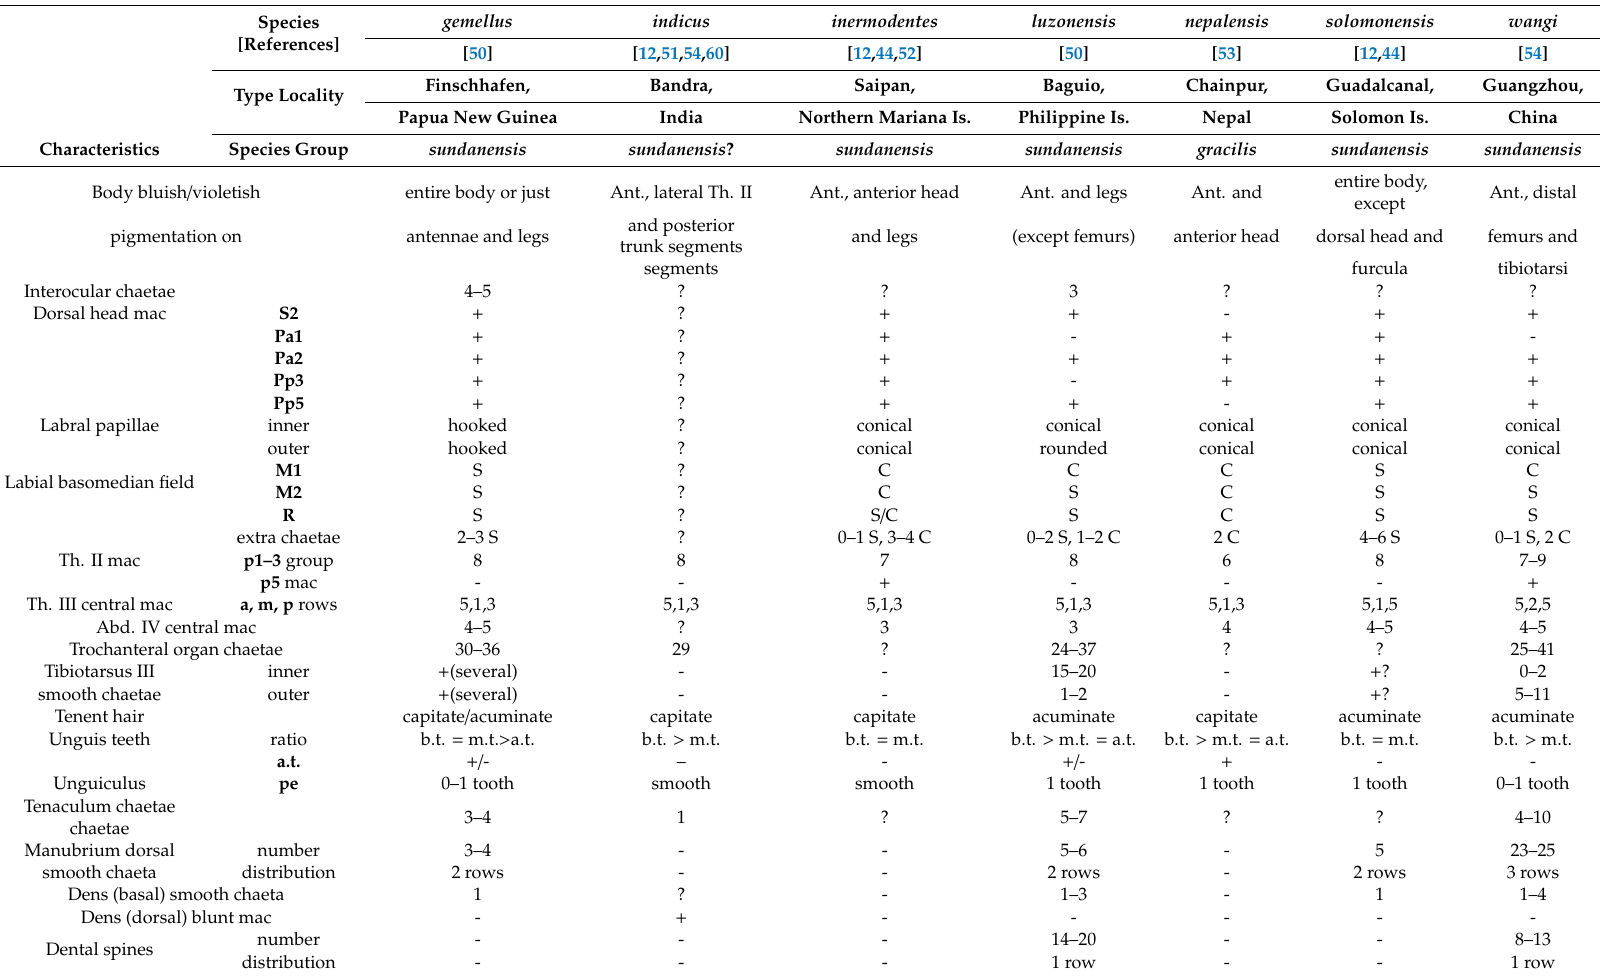
Table 4. Comparison among Dicranocentrus species from the Old Word with Abd. I–III with 3, 2 and 2 central mac,